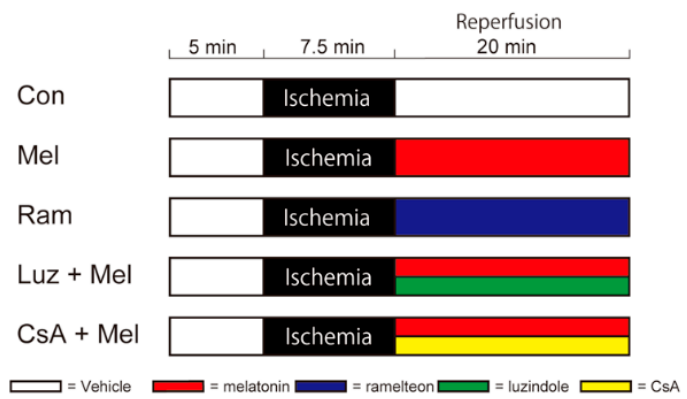
Figure 1. Diagram showing time schedules for ischemia and drug administration in each perfusion protocol. In each protocol, electrophysiological recording started collecting data 5 min before the start of ischemia and lasted up to 20 min after the reperfusion. The black band indicates the perfusion period during ischemia. White bands indicate perfusion with artificial cerebrospinal fluid. Red, blue, green, and yellow bands indicate administrations of melatonin, ramelteon, luzindole, and cyclosporine A in artificial cerebrospinal fluid, respectively. Con—control; Mel—melatonin; Ram— ramelteon; Luz—luzindole; CsA—cyclosporine A.